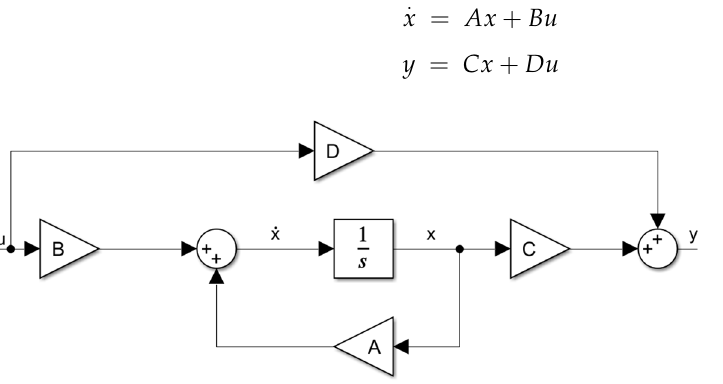
Figure 3. State Space Block Diagram— 1 representing integrator block in MATLAB Simulink. s The A matrix is the system matrix and contains the state information of the system.